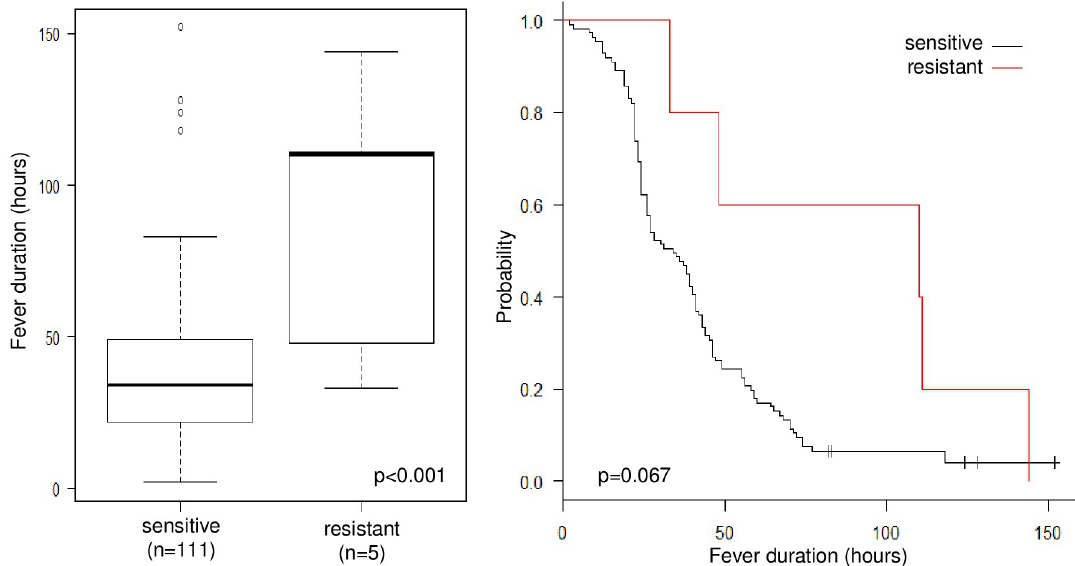
Fig 5. Fever duration comparison between A/H1N1pdm09 oseltamivir-resistant and oseltamivir-sensitive patient groups aged 0 to 5 years. Left: Boxplots of t-test for the average fever duration. The bold line is the average value; the box shows the interquartile range. Right: Kaplan-Meier method for fever duration. Black line: oseltamivir-sensitive; red line: oseltamivir-resistant.